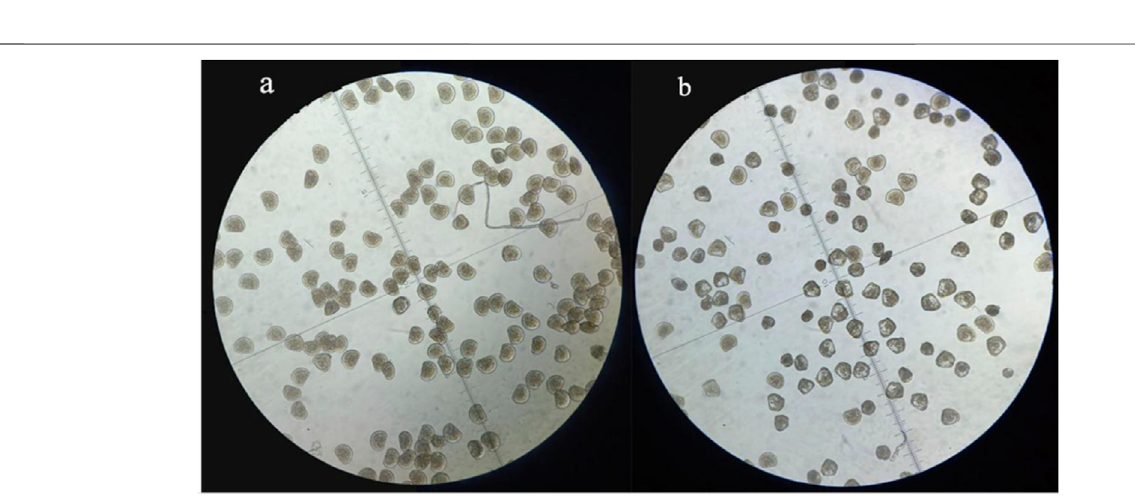
FIGURE 1 | Hatching rate of fertilized eggs treated with different concentrations of EMS.